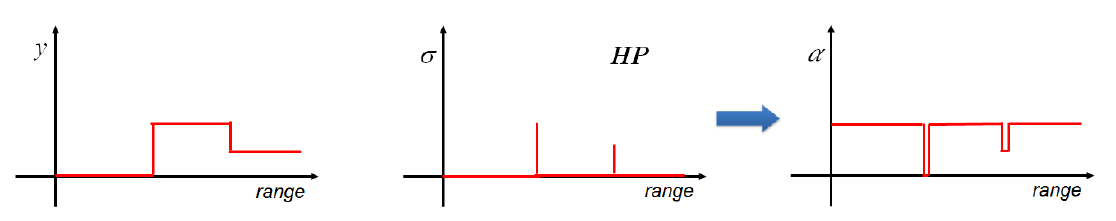
Figure 2. Example of ˆ θ MAP and α MAP on an image profile: ( left ) noise-free one, ( center ) using ˆ θ MAP , and ( right ) using α MAP